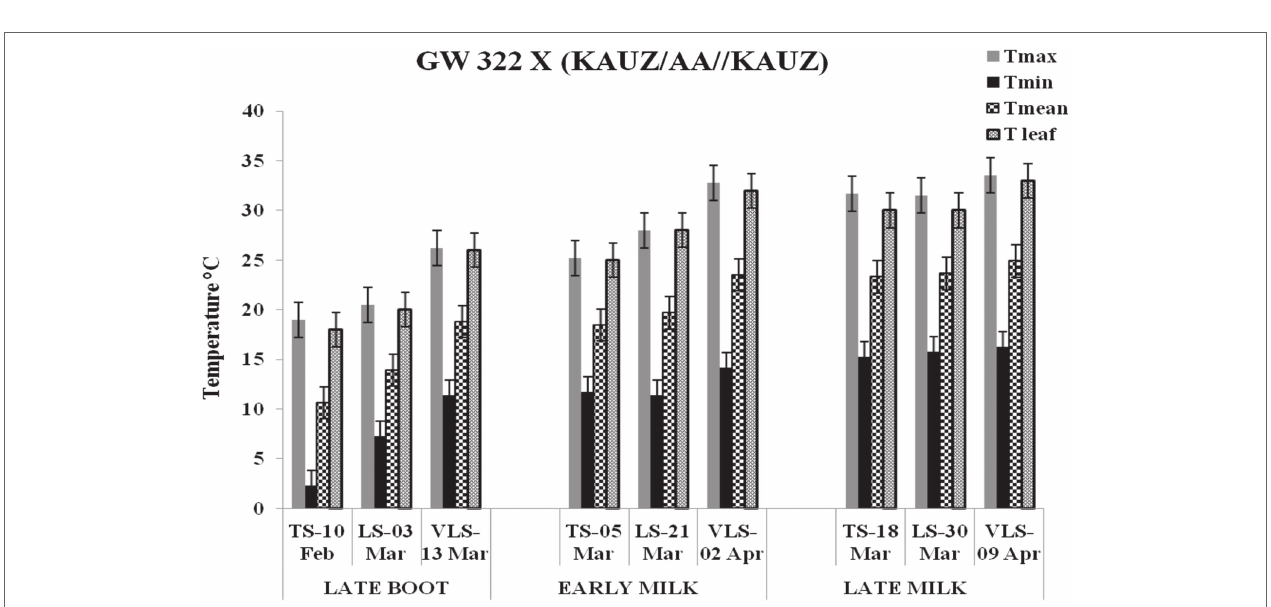
FIGURE 1 | Daily maximum temperature, minimum temperature, and mean temperature in degree Celsius during the crop growth